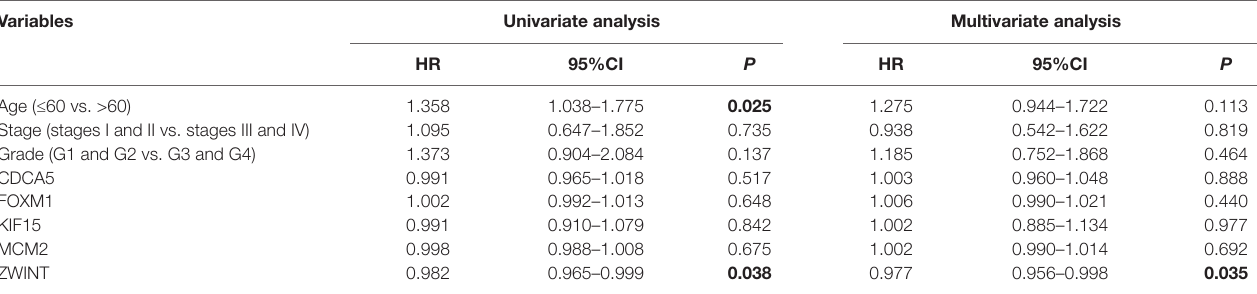
TABlE 2 | Univariate and multivariate analyses of the correlation of CDCA5, FOXM1, KIF15, MCM2, and ZWINT expression with overall survival (OS) among epithelial ovarian cancer patients. Variables Univariate analysis Multivariate analysis